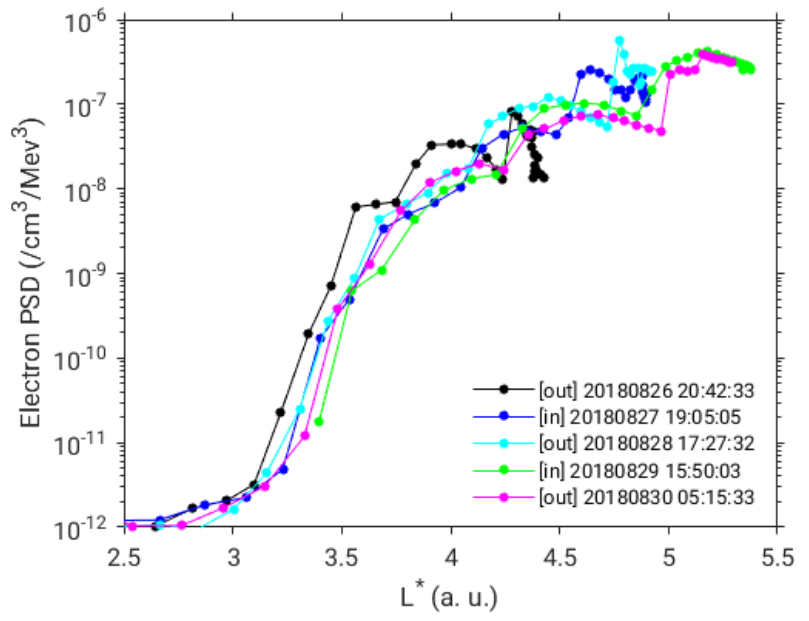
Figure 9. Radial PSD profiles at constant µ (4500 MeV ) and K (0.1 R E G 1 2 ) for RBSP-A/REPT electrons G of energies between approximately 3 MeV and 7 MeV along both inbound and outbound crossings of the radiation belts. Complementary RBSP-B/REPT profiles (not shown) are consistent with their A